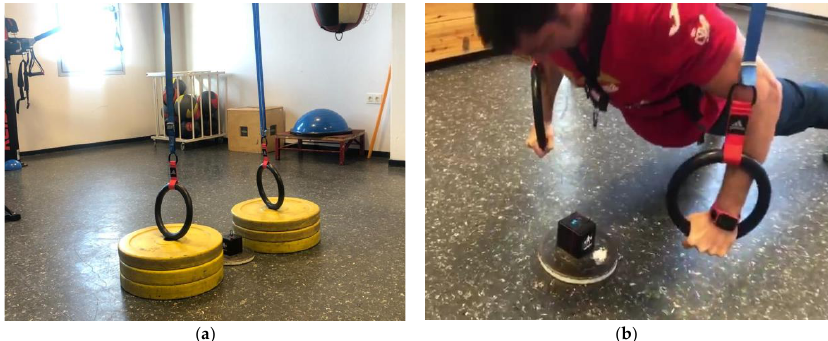
Figure 2. ( a ) Placement of the unstable material at the same height from the ground in both stable and unstable conditions; ( b ) Attachment of the linear velocity transducer to the waistcoat carried by the